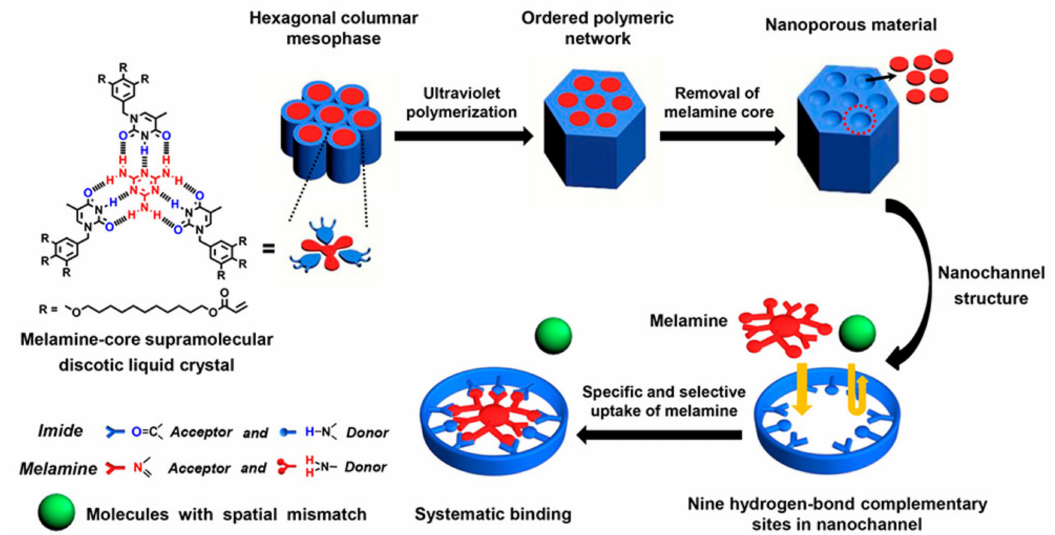
Figure 10. Schematic illustration of the design and fabrication of supramolecular discotic LC polymeric material for specific and selective uptake of melamine. Reprinted with permission from reference [142]. Copyright (2020) American Chemical